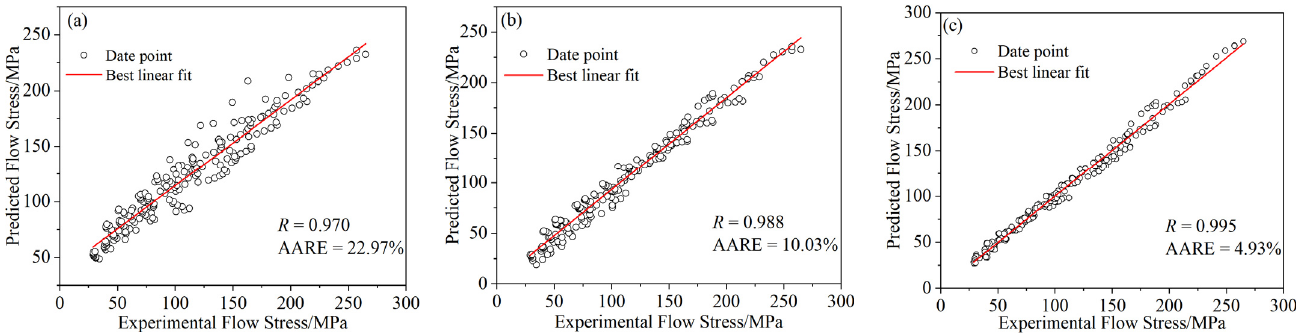
Figure 11. Correlation between the predicted and experimental flow stress values from: ( a ) Johnson– Cook model; ( b ) Modified Johnson–Cook model; ( c ) Strain-compensated Arrhenius model.